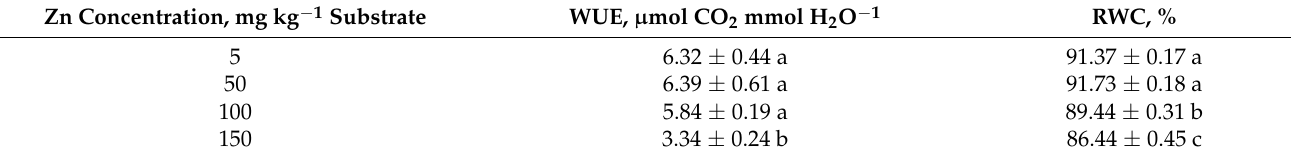
Table 4. Effect of Zn excess on water content in S. alba